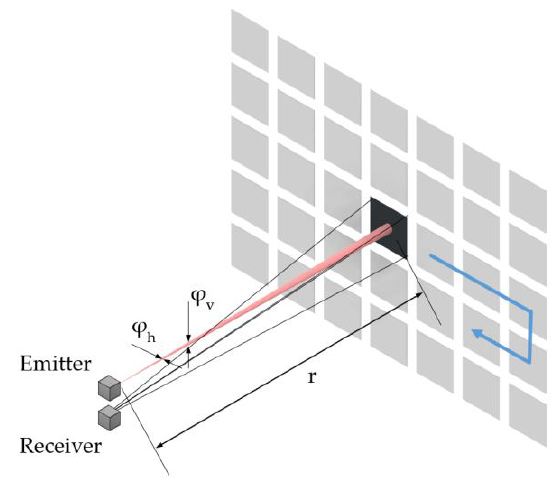
Figure A2. Spot Figure A2. Spot irradiation.